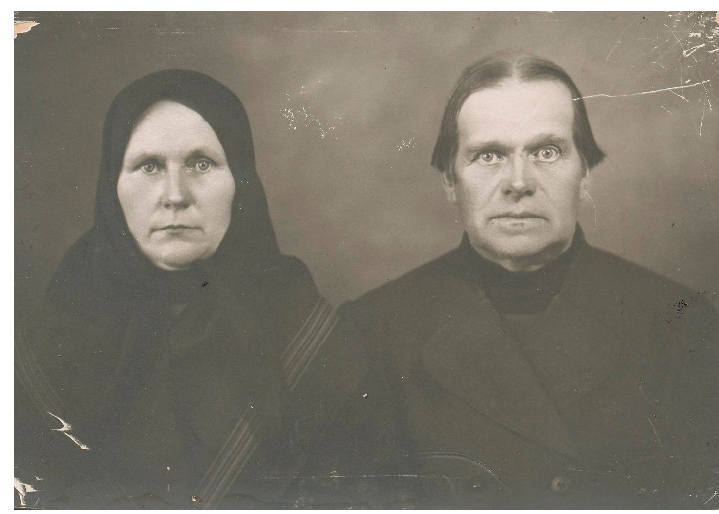
Figure 2. Author’s great-grandparents in körtti dress, c. 1920s/1930s. Photograph: family album.